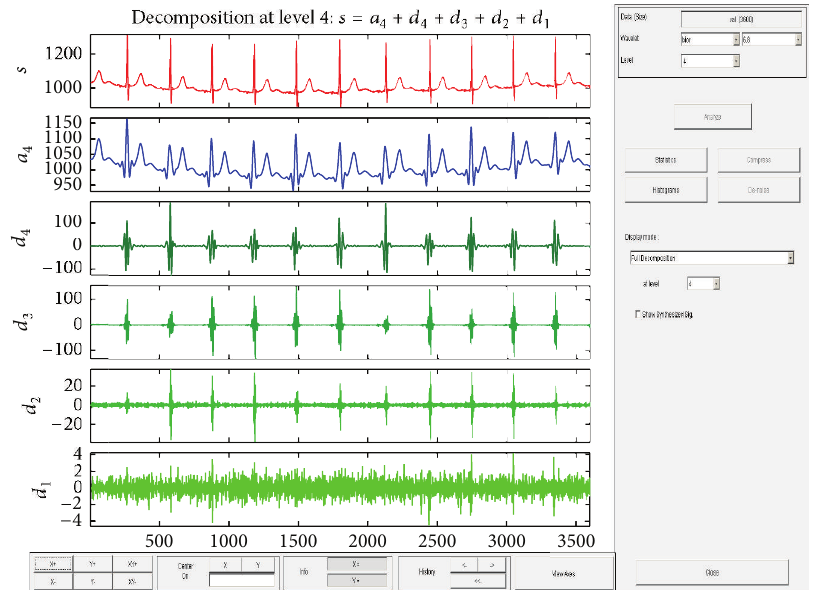
Figure 2: Wavelet denoising for ECG record no 103m using Biorthogonal 1D wavelet.